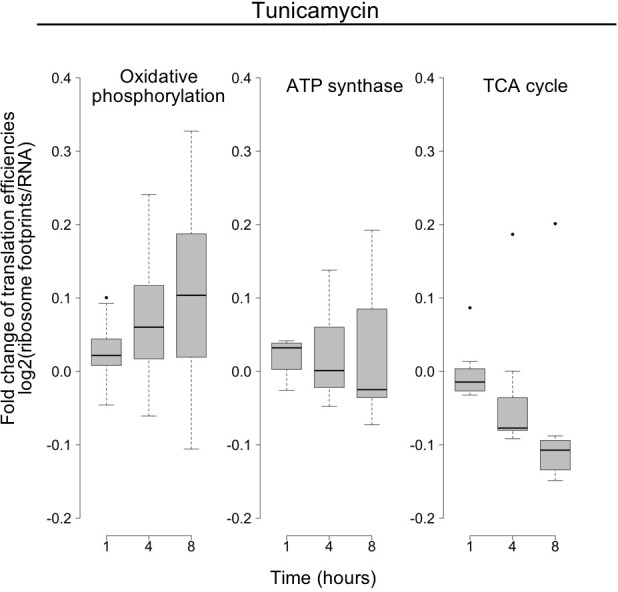
Translation changes of oxidative phosphorylation and related genes.The panels show the time-dependent changes in translation efficiency for specified gene families responding to tunicamycin treatment, as a summary of what is shown in Figure 5C,D in the main text. Changes in the log base 2 ratio of ribosome footprints by RNA abundance as a proxy of translation efficiency, averaged over all genes within a given group and replicates. Oxidative phosphorylation N = 46; ATP synthase N = 10; TCA cycle N = 7.